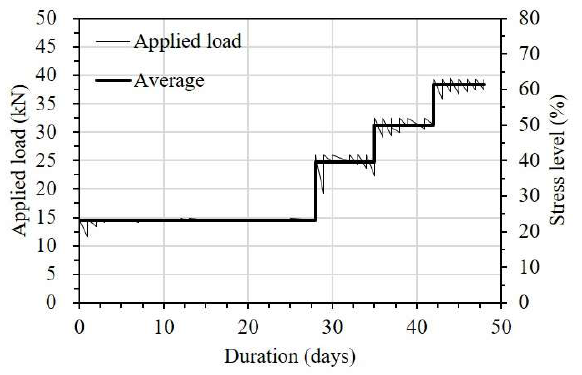
Figure 10. Loading history for the short-term creep test.